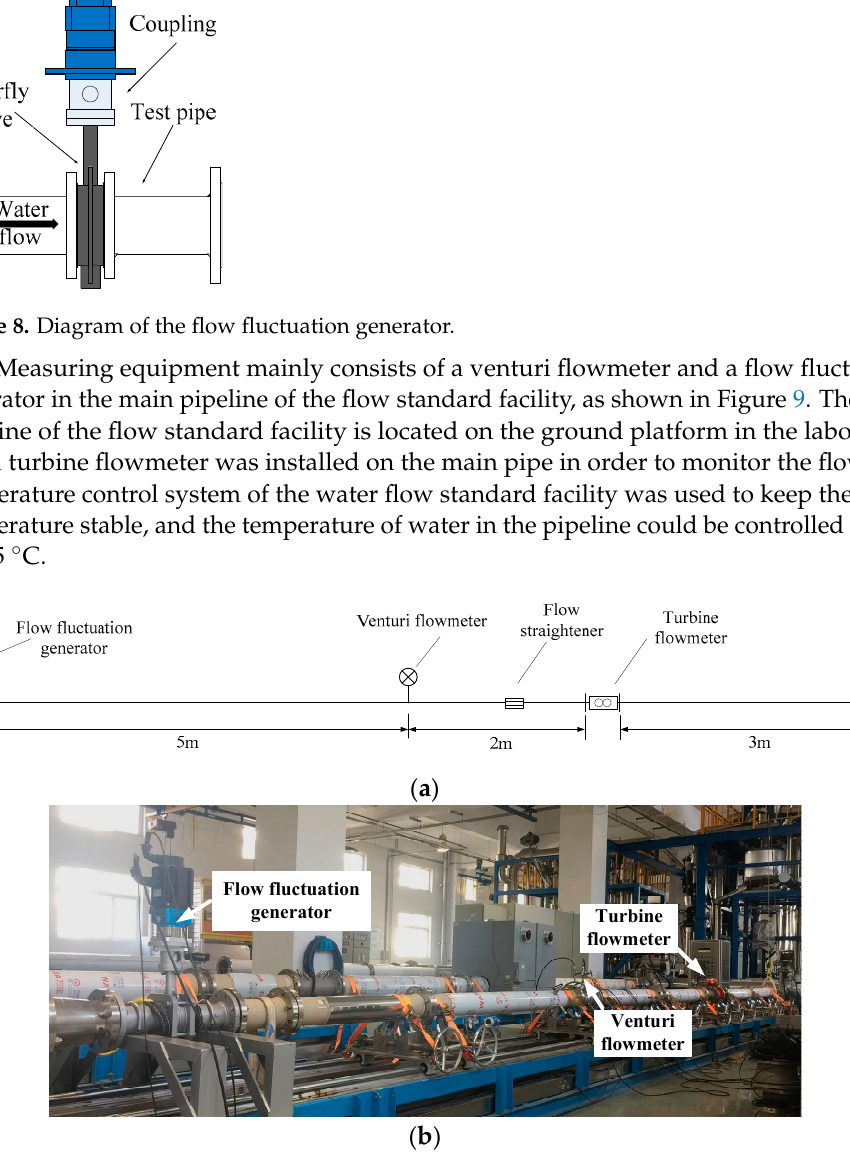
Figure 9. The main pipeline and photo of experimental setup: ( a ) the main pipeline of the flow standard facility; ( b ) photo of experimental setup in the flow standard